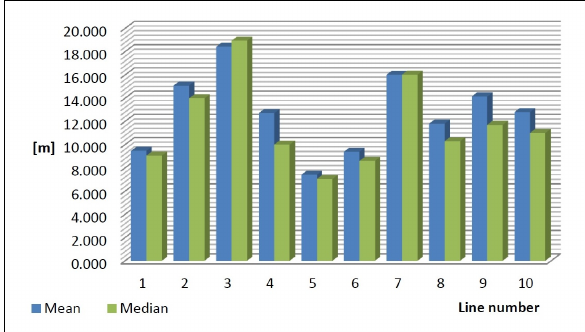
Figure 8. Mean and median histogram for the test site Serbia